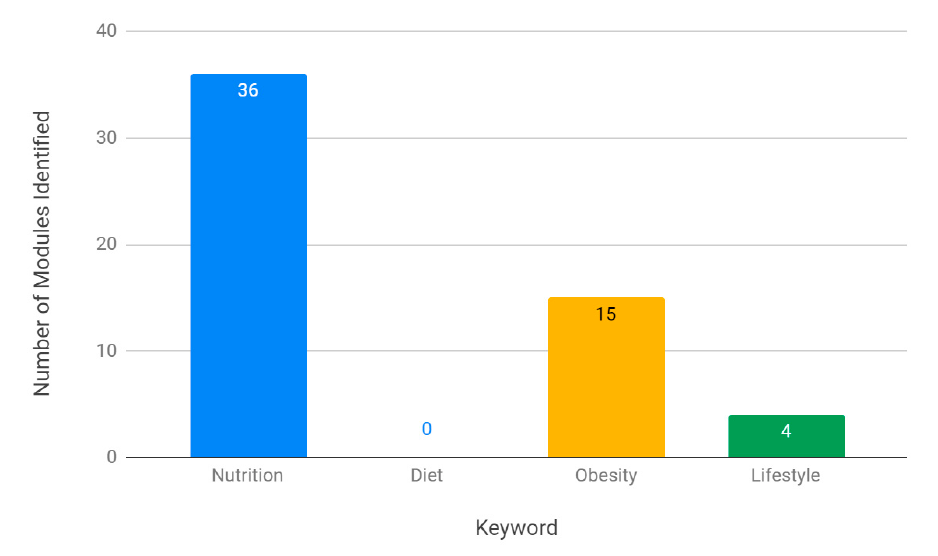
Figure 3. Number of nutrition-related modules per keyword across specialties.